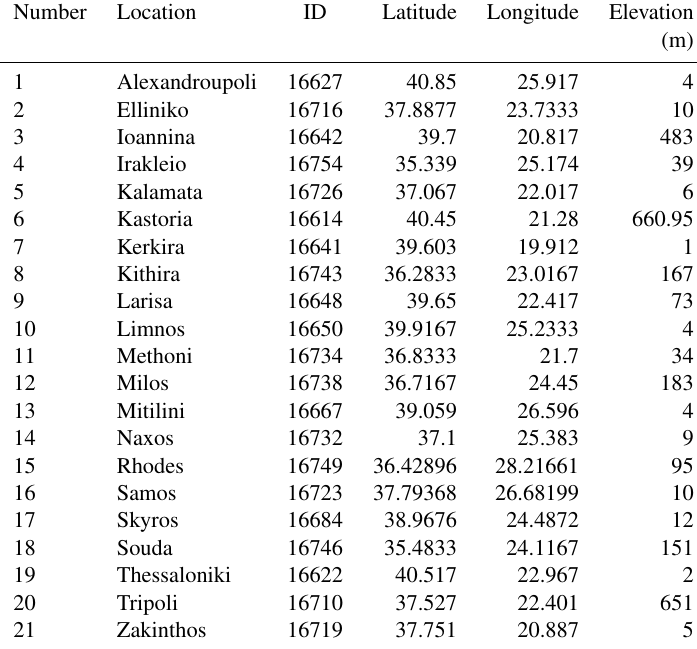
Table A1. HNMS stations information.